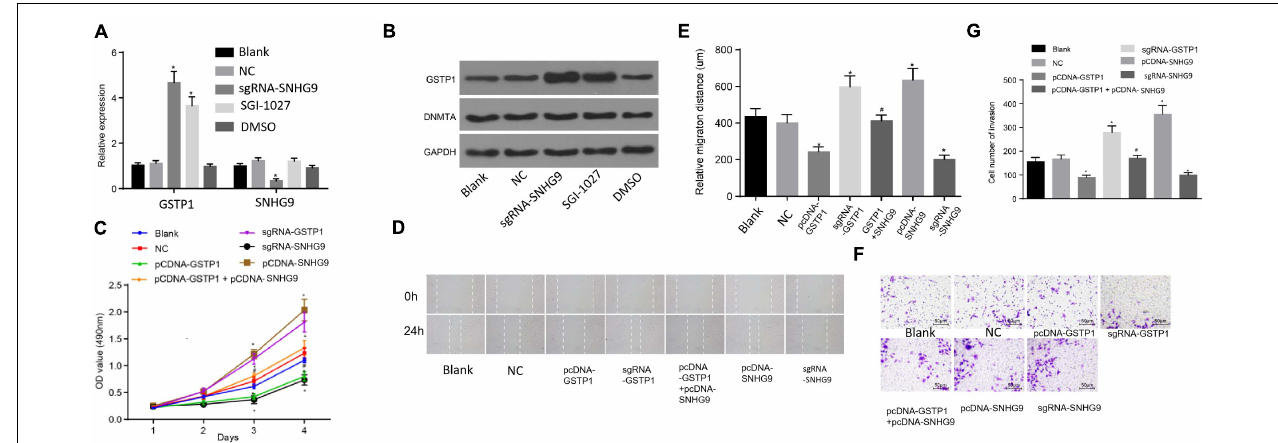
FIGURE 5 | Knockdown of SNHG9 can inhibit the proliferation, migration, and invasion of HCC cells by upregulating GSTP1. (A) The expression of SNHG9 and GSTP1 after sgRNA-SNHG9 and SGI-1027 treatment and detected by RT-qPCR; (B) Western blot analysis of GSTP1 and DNMT after treatment with sg-SNHG9 and SGI-1027; (C) The proliferation of hepatocellular carcinoma cells treated with sgRNA-SNHG9, sgRNA-GSTP1, PCDNA-GSTP1, PCDNA-SNHG9, and PCDNA-GSTP1 + SNHG9 as detected by the CCK-8 method. Panels (D,E) were used to detect the migration of hepatocellular carcinoma cells treated